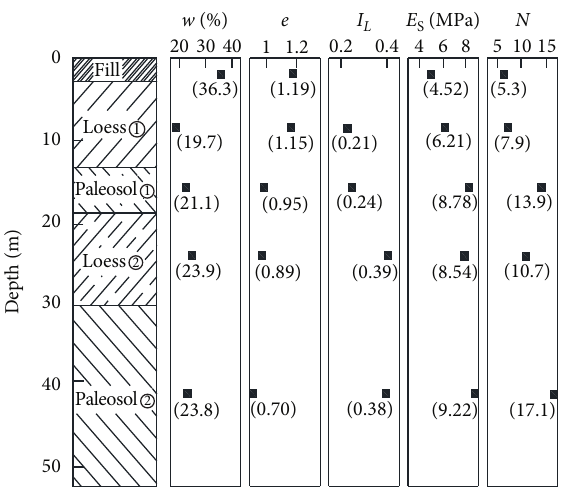
Figure 2: Geotechnical profile and soil properties of the construction site. Table 1: Physical and mechanical parameters of the soil layer. Layer no.